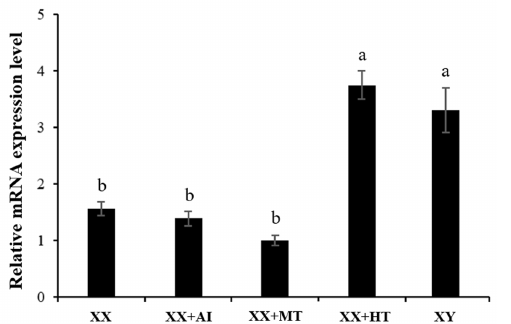
Figure 6. Gonadal Jarid2b expression responds to 17-Methytestosterone (MT) and letrozole (AI) treatment at 21 dpf. XX + MT: genetically XX Nile tilapia with 17-Methyltestosterone treatment under 28 °C temperature water; XX + AI: genetically XX Nile tilapia with letrozole (AI) treatment under 28 °C temperature water; XX: control female group; XX + HT: high-temperature-treated female group; XY: control male group. The expression level in the gonad of the XX group was defined as 1, following normalization to the β -actin expression. The different letters indicate significant differences among treatments ( p < 0.05).